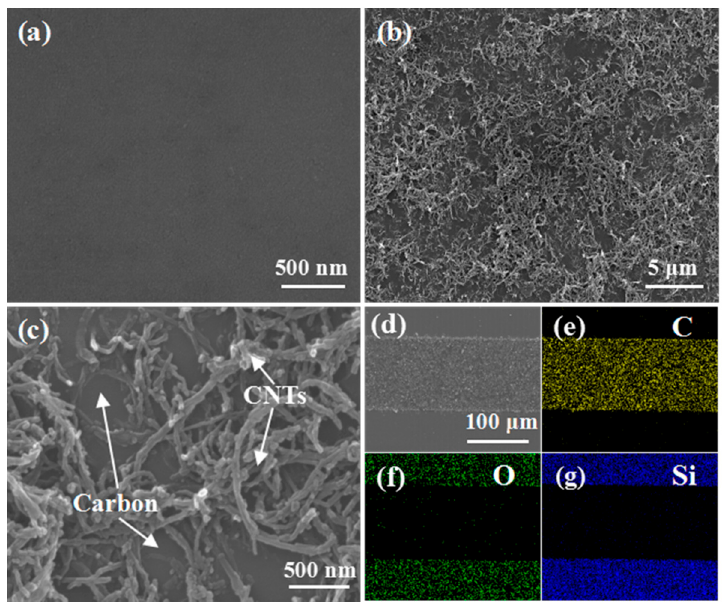
Figure 3. ( a ) SEM image of the surface of pyrolyzed carbon. ( b ) Low-magnification SEM image of carbon / CNT microelectrode surface. ( c ) High-magnification SEM image of carbon / CNT microelectrode surface. ( d ) SEM image of a carbon / CNT microelectrode. ( e – g ) Corresponding C / O / Si element mapping of carbon / CNTs